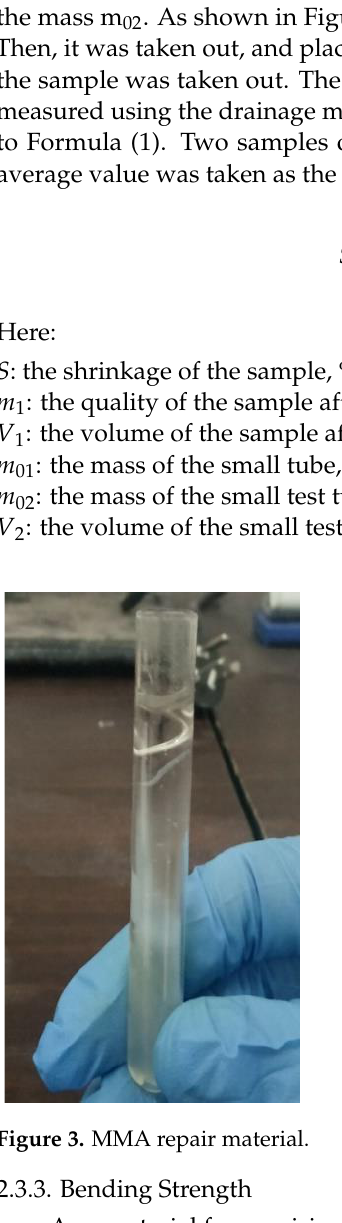
Figure 2. Pointer rotary viscometer NDJ-1.